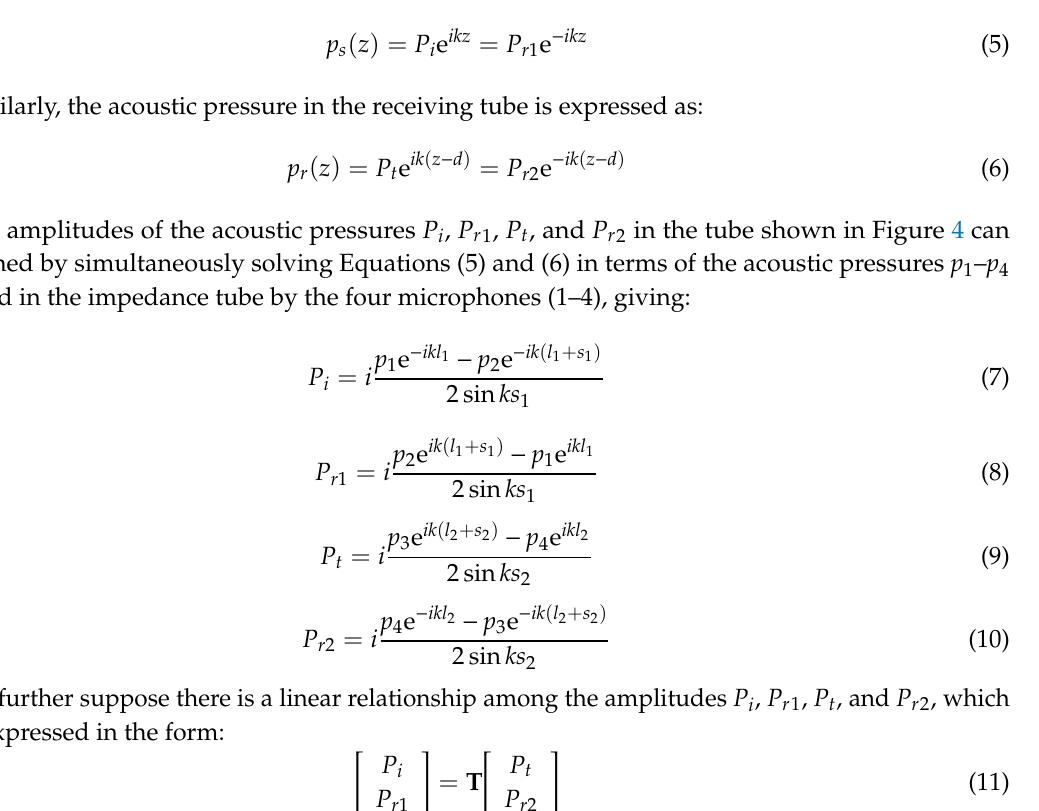
Figure 5. Schematic diagram showing the components of the impedance tube.